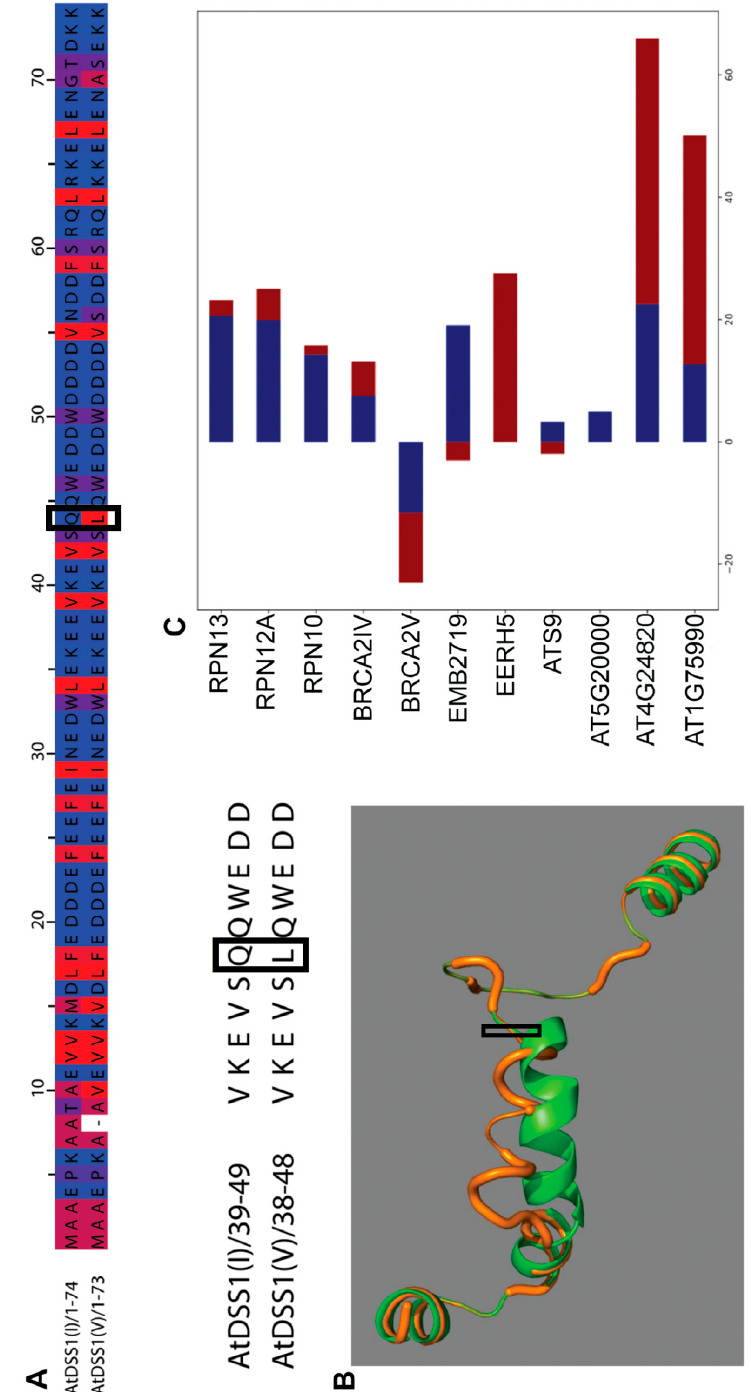
Figure 1. In silico DSS1 protein analysis. ( A ) DSS1(I) and DSS1(V) primary amino acid sequence alignment colored by hydrophobicity: hydrophobic—red, hydrophilic—blue; ( B ) visual comparison of DSS1(I) and DSS1(V) proteins using superimposed 3D protein models obtained using PHYRE V 2.0; black squares depict Q44L; ( C ) Binding energy of the solution in kcal/mol, given for specific partners. Blue and red represent the potential interaction of DSS1(I) and DSS1(V), respectively. The PPI (protein-protein interaction) properties were calculated using PatchDock and FireDock.